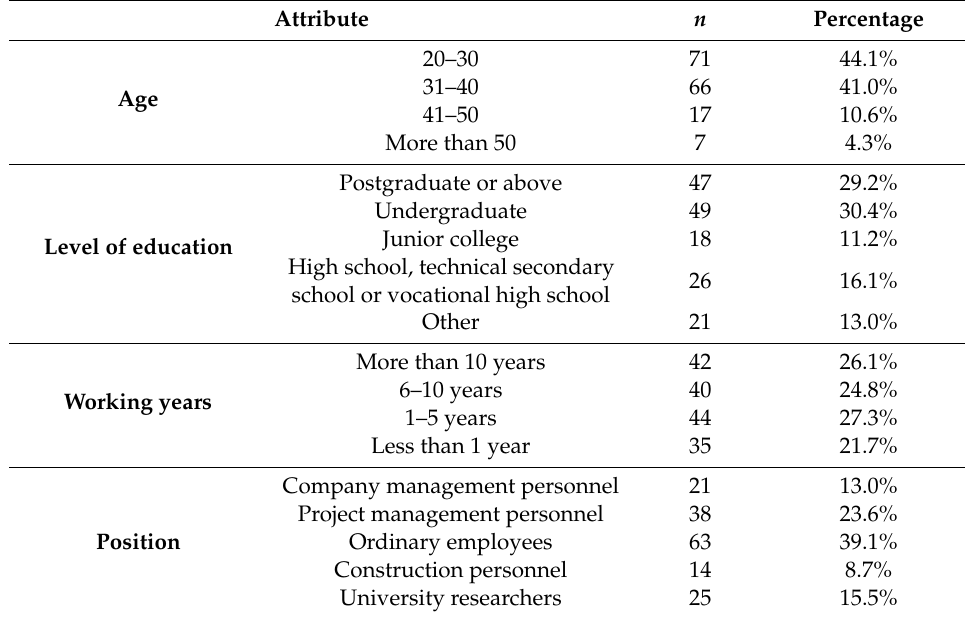
Table 3. Demographic characteristics of respondents ( N = 161).